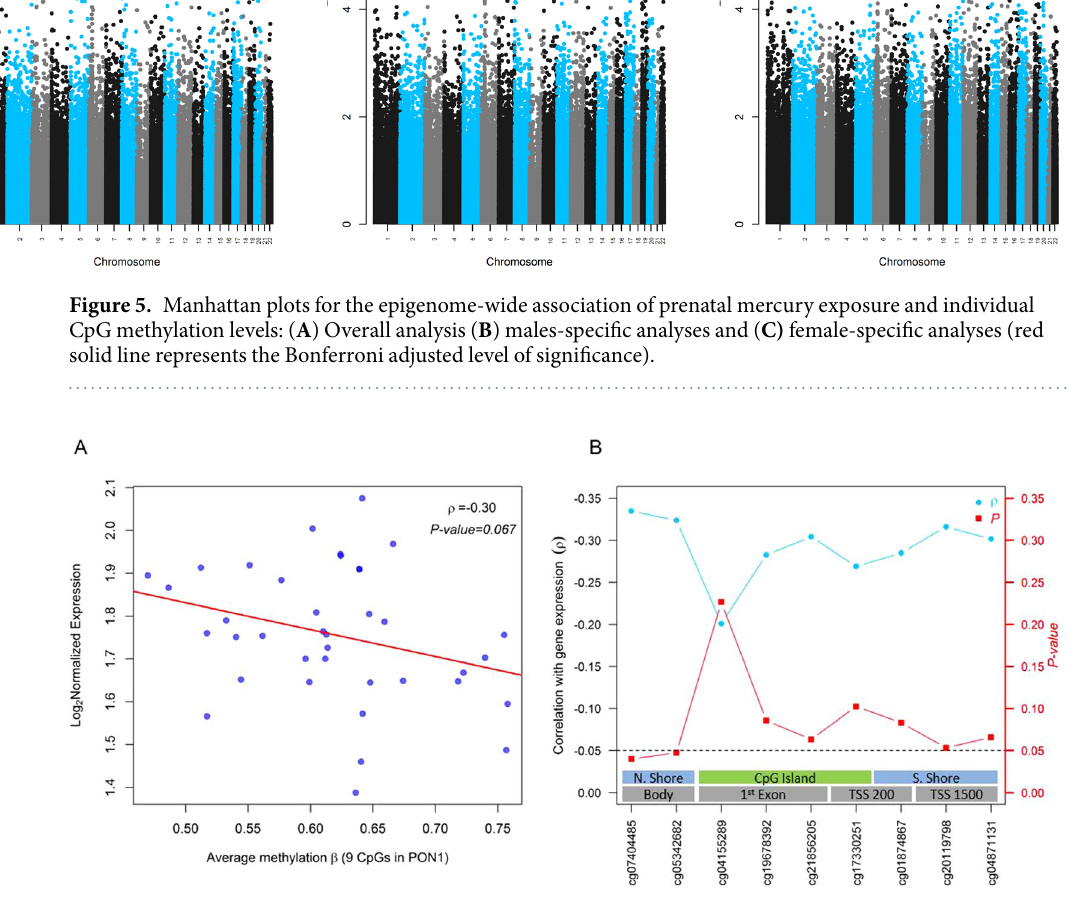
Figure 6. Association between DNA methylation and gene expression of the PON1 gene at the DMR associated with prenatal mercury exposure from an independent birth cohort (N = 38): ( A ) scatter plot of mean methylation levels of the DMR in PON1 and gene expression and ( B ) individual correlation coefficients and corresponding P -values for each individual CpG site in the